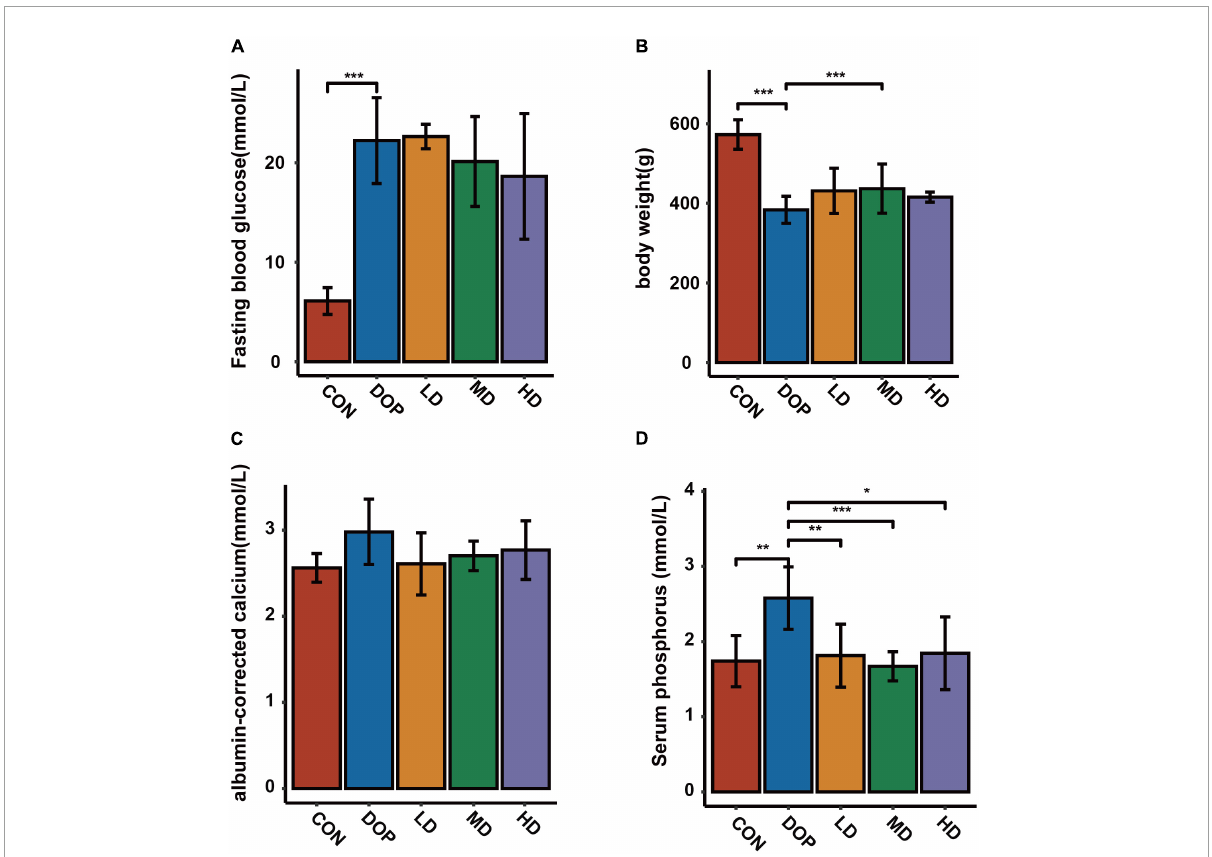
FIGURE1 Effects of S-Equol on body weight, fasting blood glucose, serum albumin-corrected calcium and phosphorus levels in different groups of rats after 12 weeks of gastric gavage. (A) Fasting blood glucose levels; (B) body weight of rats; (C) serum albumin-corrected calcium levels; (D) serum phosphorus levels. All data are expressed as mean ± SD ( n = 7 for body weight and fasting blood glucose levels). * p < 0.05, ** p < 0.01, *** p < 0.001 as compared to the DOP